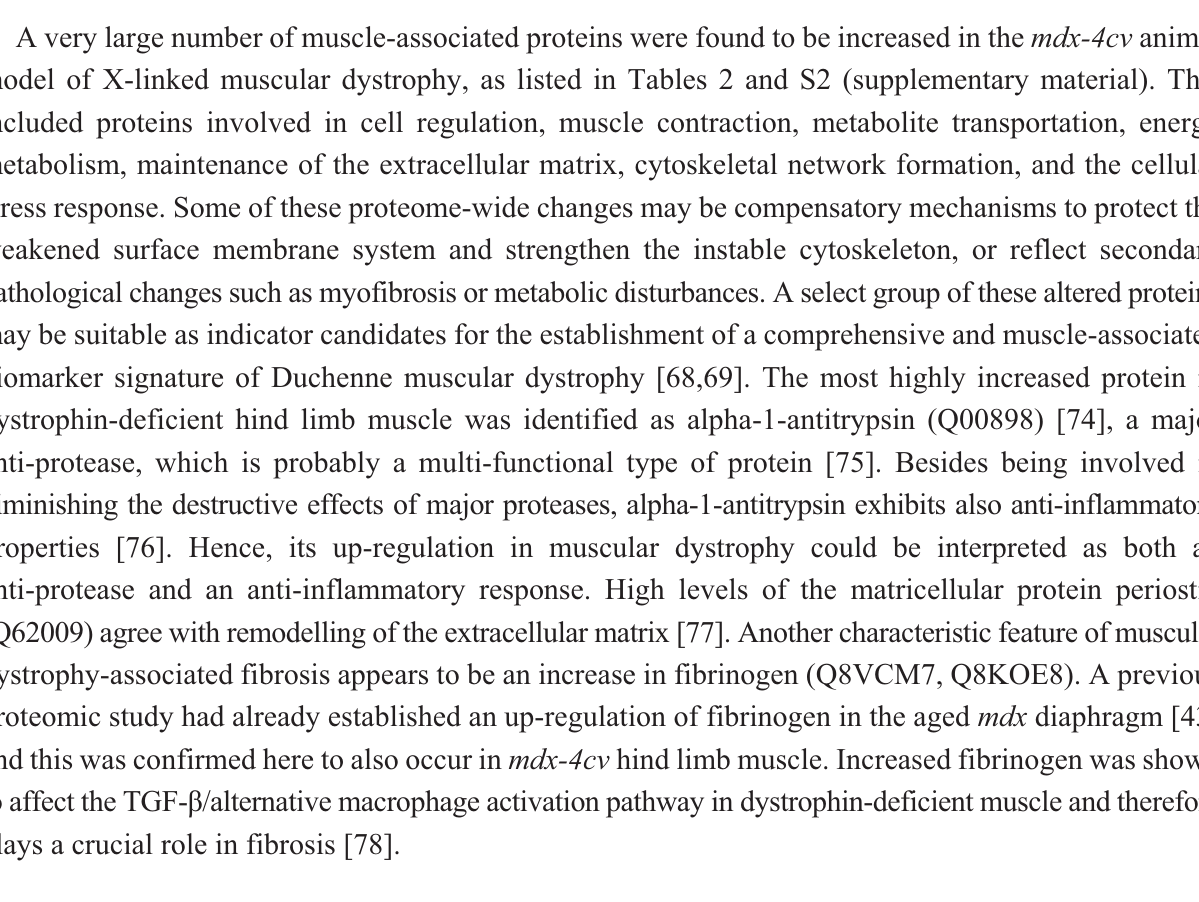
Table 2. List of changed proteins with an increased concentration of more than 5-fold in the mdx-4cv microsomal fraction (Table S2 in the supplementary materials lists additional proteomic